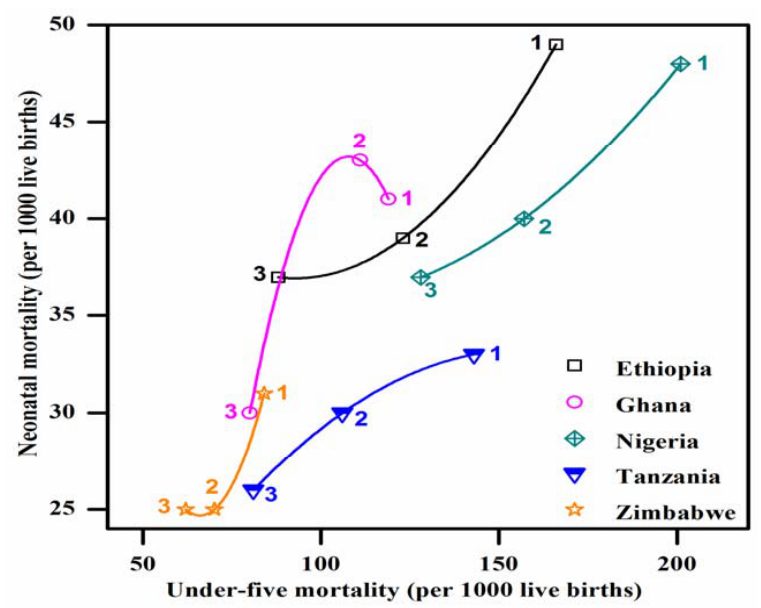
Figure 4. Under ‐ five mortality vs. neonatal mortality: African countries. Each data point is labelled 1, 2, and 3 for each country, where 1 and 3 denote the earliest and latest DHS, respectively.